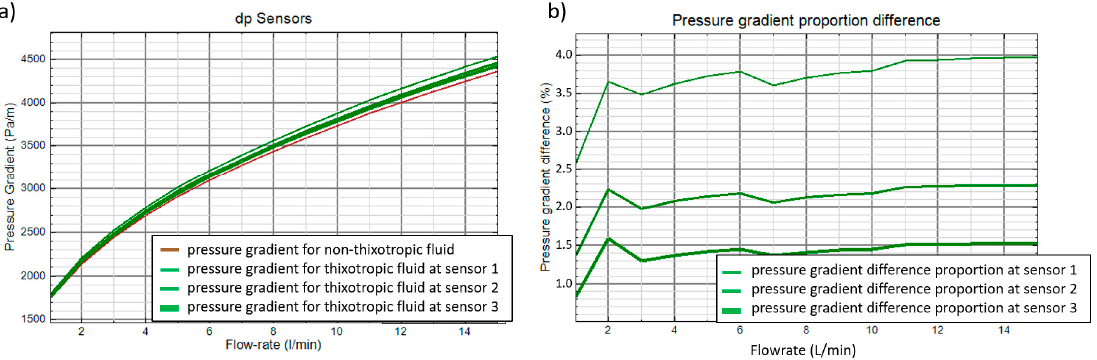
Figure 21. ( a ) Estimated pressure gradients at the position of the sensors along the flow-loop for non-thixotropic and thixotropic fluid having the same steady state rheological behavior, ( b ) percentage of the pressure gradient difference for the thixotropic fluid with regards to the non-thixotropic fluid.